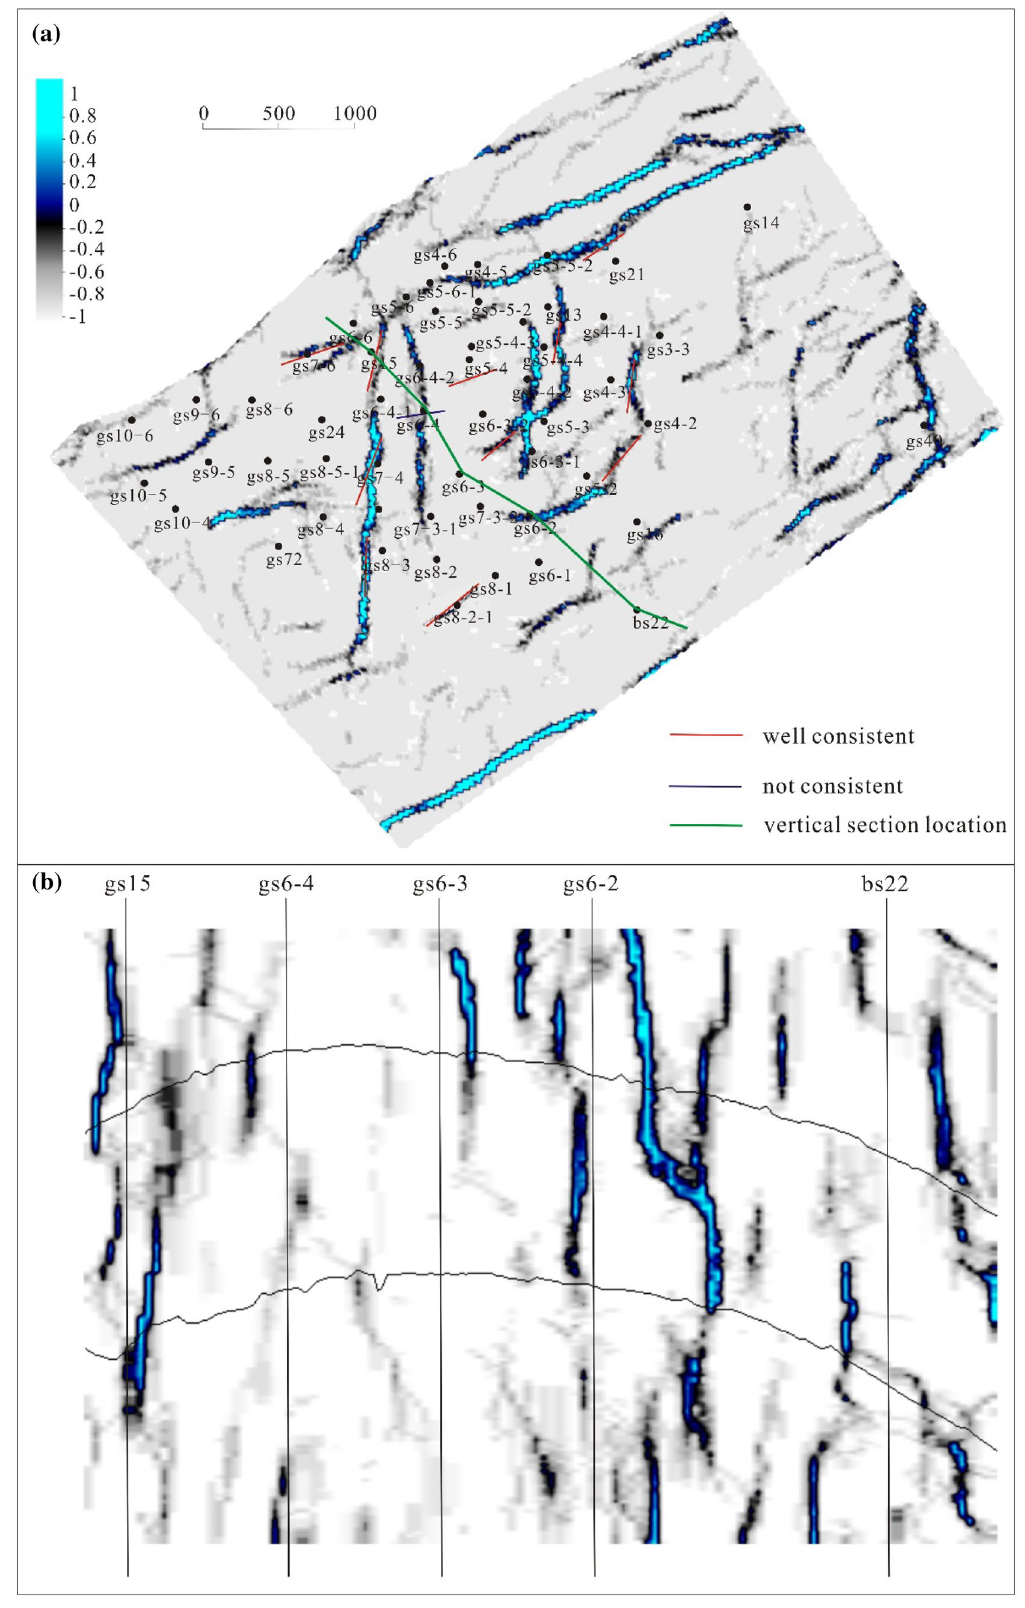
Fig. 7 Ant-tracking prediction of fractures in Maxi Oilfield. a Slice of ant-tracking attribute. b. Vertical section of ant-tracking